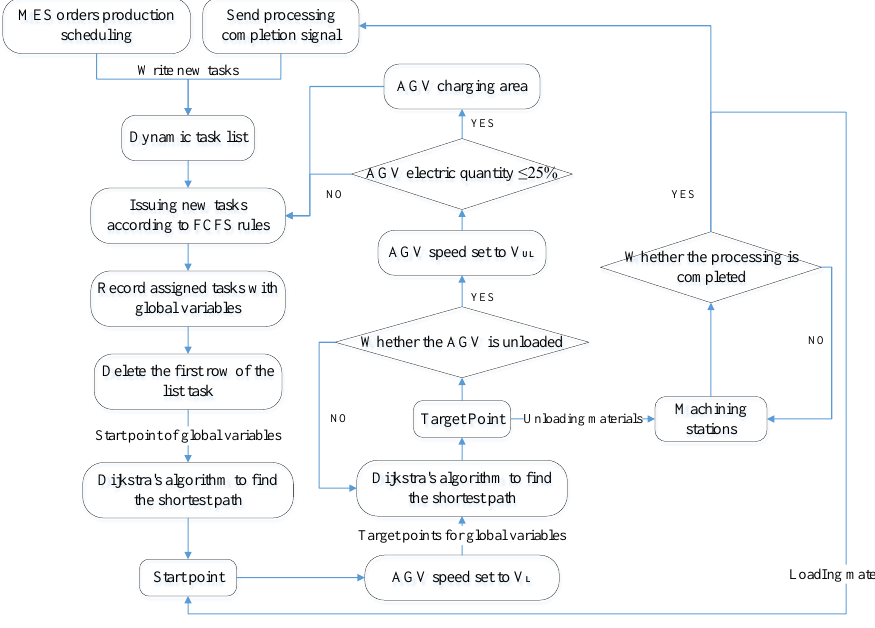
Figure 8. Intelligent algorithm flowchart.